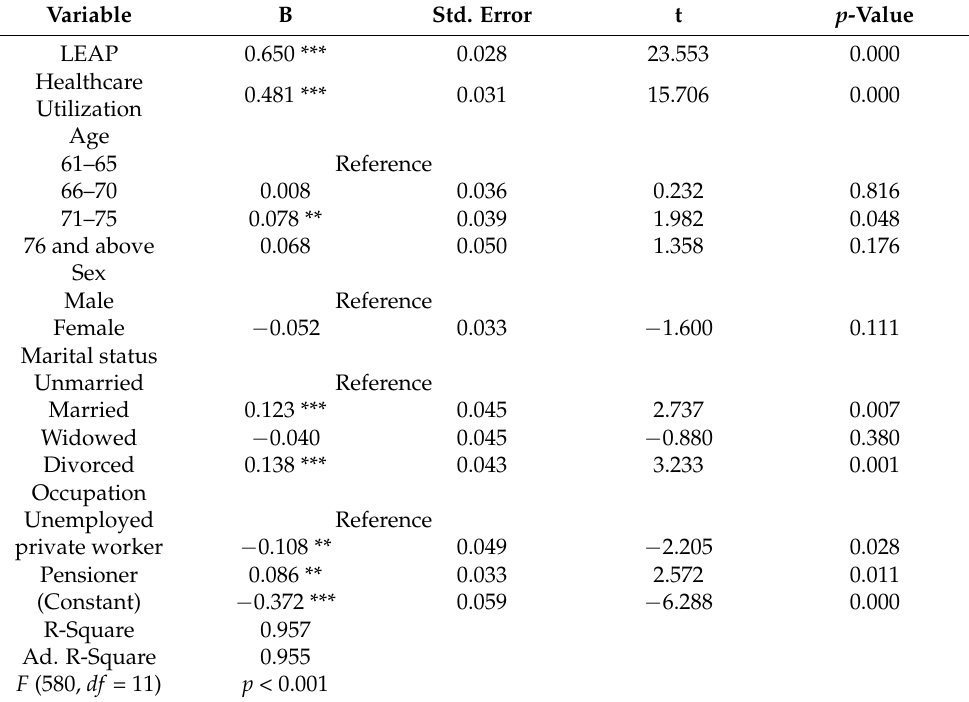
Table 5. Regression Model 2: (Dependent Variable: Older Adults Health